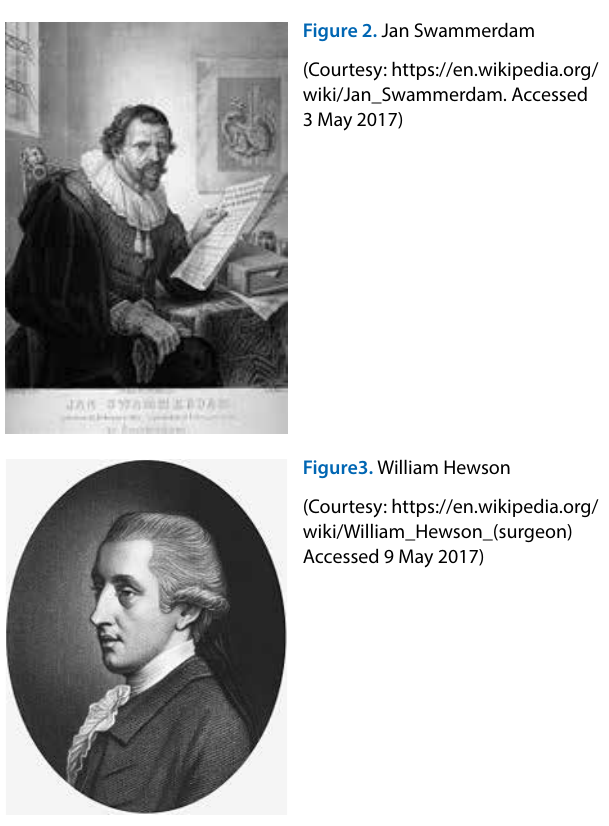
Figure3. William